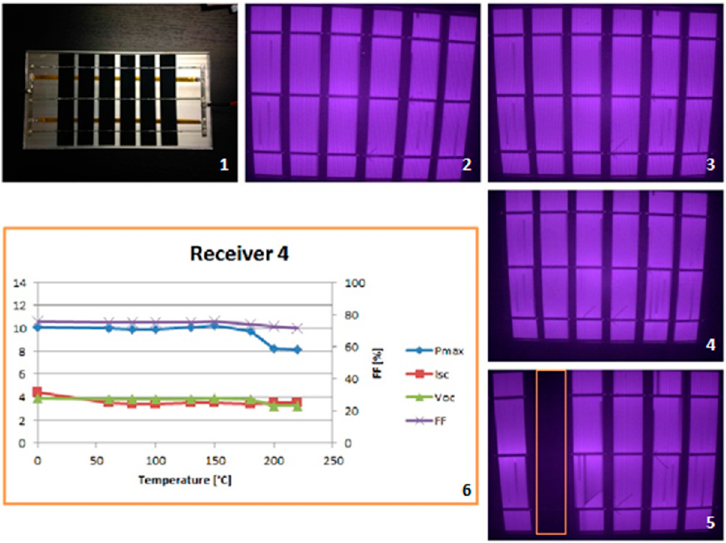
Figure 12. ( 1 ) Receiver 4; ( 2 ) Baseline Round; ( 3 ) Round 5 (150 °C); ( 4 ) Round 6 (180 °C); ( 5 ) Round 8 (220 °C); ( 6 ) Parameters of the IV curve at different temperatures (Isc, Voc and Pmax shown in the left Y axis and FF in the right Y axis).